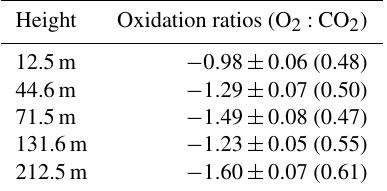
Table 2. The CO 2 and O 2 correlation coefficients at the different height levels derived using the least-squares fit and the correlation coefficients ( r 2 ). Uncertainties are calculated as the standard error of the